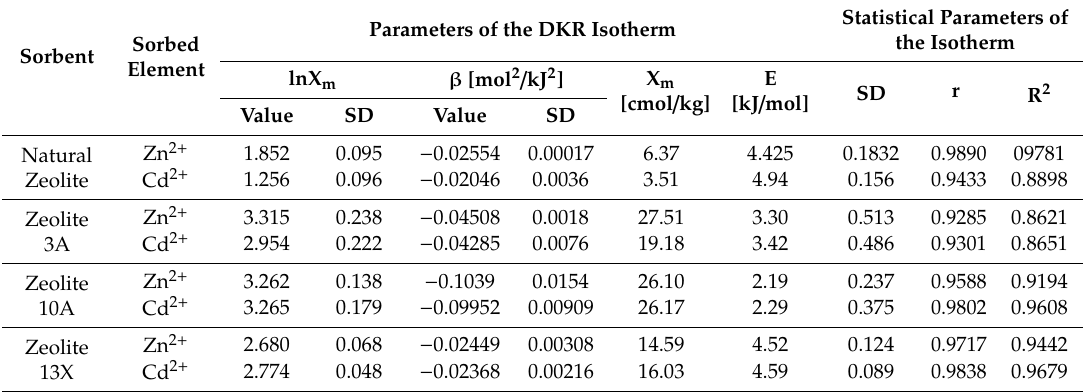
Table 5. The parameters of the determined DKR (Dubynin-Karganer-Radushkevich) isotherms.